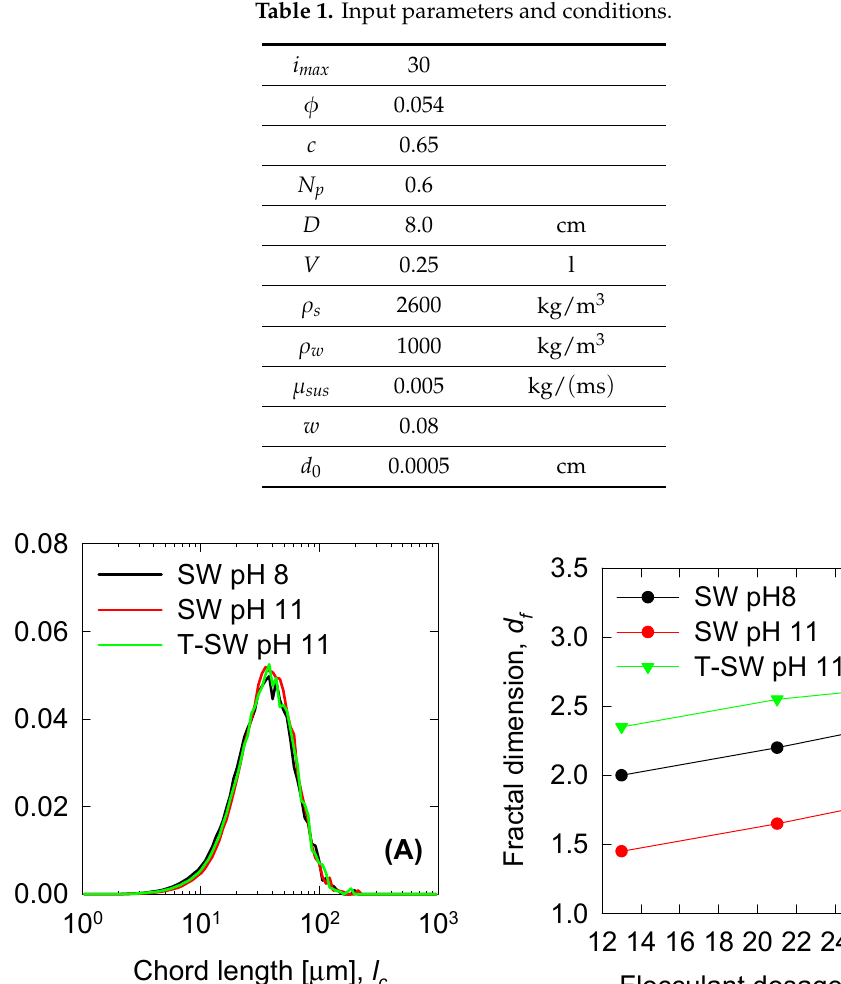
Table 1. Input parameters and conditions.